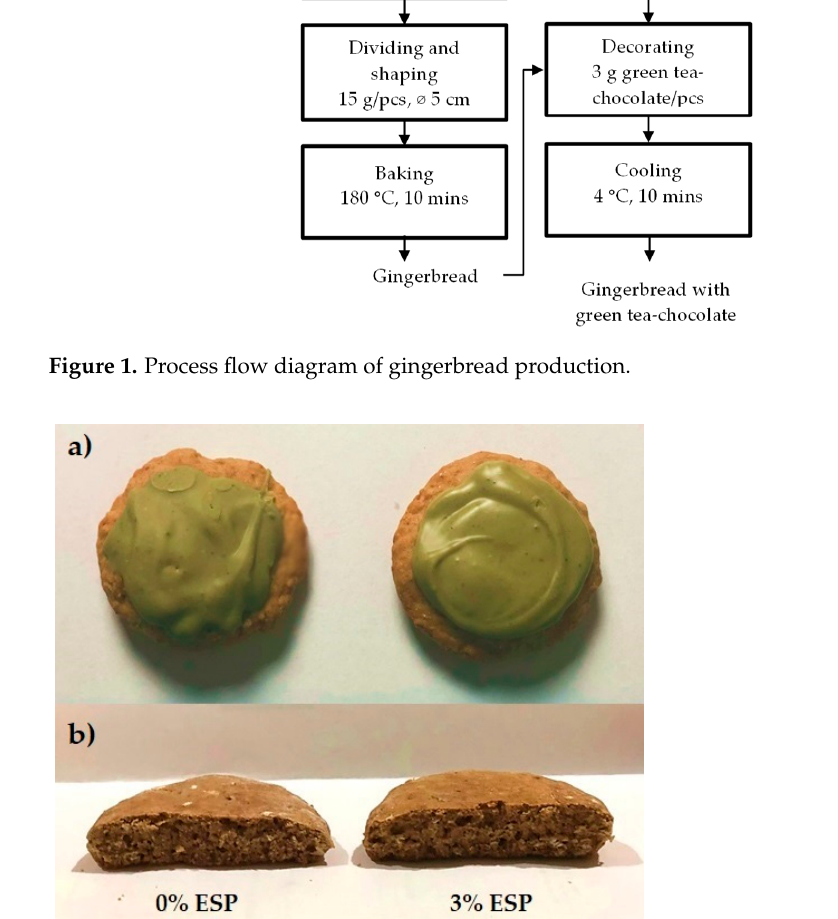
Figure 2. Gingerbread samples with ( a ) and without green tea chocolate topping ( b ); ESP: eggshell powder .